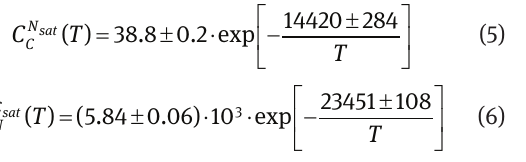
Fig. 3: The best fit equations for the solubility of carbon in liquid silicon. The dashed curve indicates the solubility limit in the pure Si–C-system [5], while the solid curve and experimental points indicates the solubility in the nitrogen-saturated